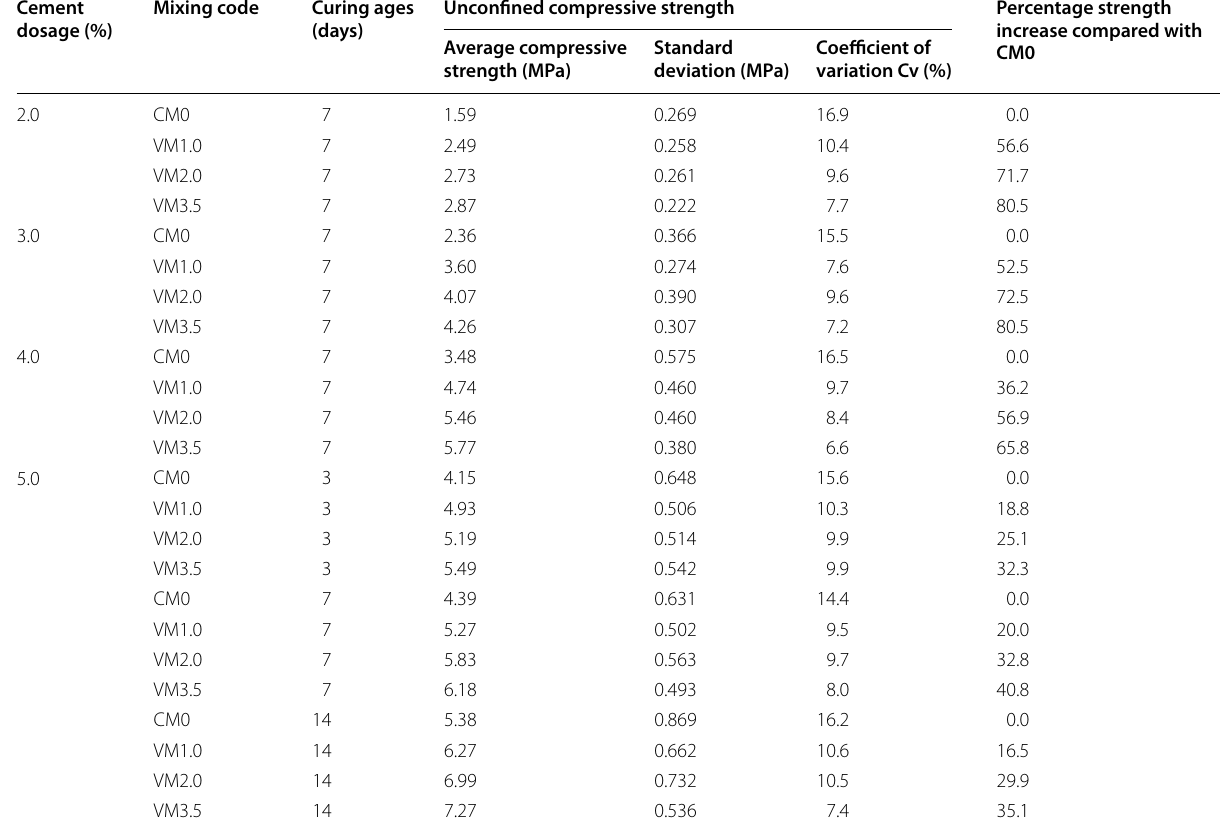
Table 4 Unconfined compressive strength results of CSM under different mixing conditions. Cement dosage (%)